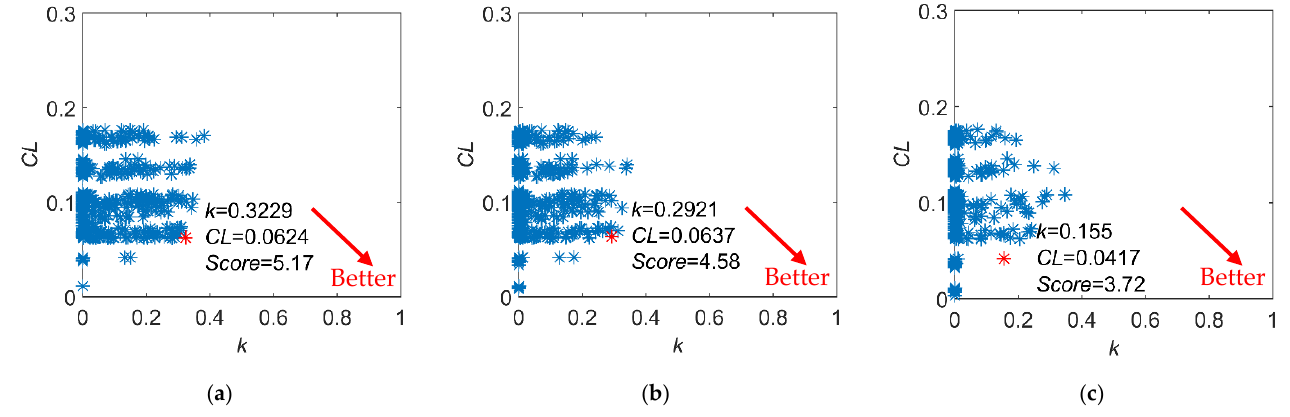
Figure 11. The evaluation results of traversing different number of indices: (a), (b), (c) are the results of p = 4, 5, 6, respectively, k is the independence coefficient, and CL is the comprehensive loss rate of the contribution rate. ( a ) p = 4. ( b ) p = 5. ( c ) p =